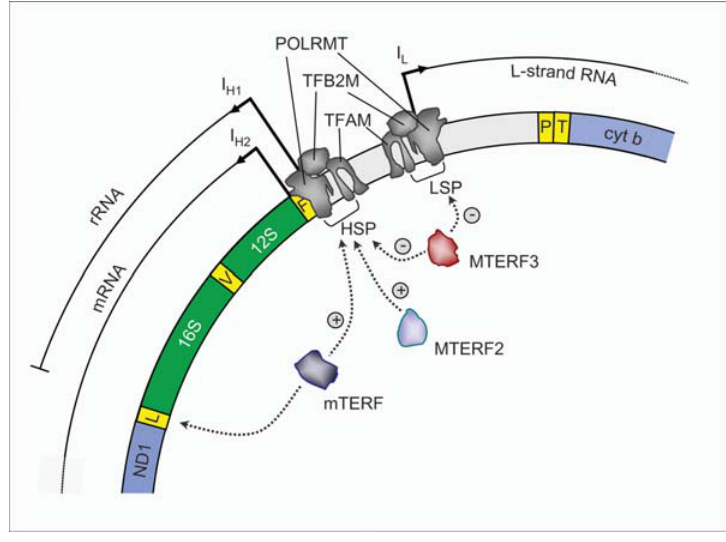
Figure 2 Schematic representation of transcription regulatory regions and factors in human mtDNA. Light grey: D-loop region containing promoters HSP and LSP. Transcription initiation is assisted by factors TFAM and TFB2M. Transcription of rDNA region initiates at I and ends at the 3 9 end of 16S rRNA gene. Transcription termination is mediated by mTERF which binds inside tRNA Leu(UUR) gene. Simultaneous binding of mTERF to promoter and termination sites causes rDNA looping and allows recycling of POLRMT between both regions. I directs transcription of entire H-strand, giving rise to a polycistronic RNA precursor molecule. I H2 strand DNA, generating a polycistronic transcript and RNA primers for H-strand replication. Transcription repressor MTERF3 and tran- scription activator MTERF2 are shown to contact sequences in the promoter region. Symbols ∞ and ] : activation and repression,